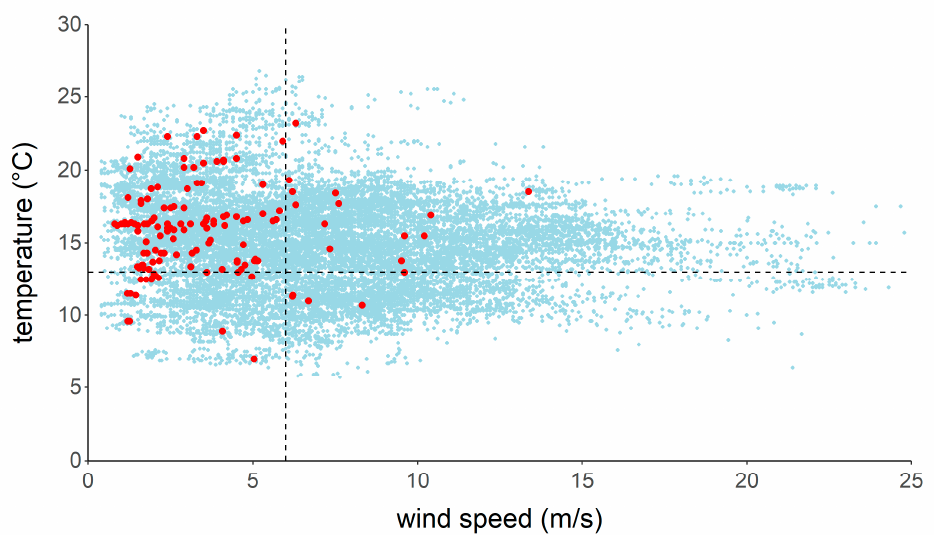
Figure 7. Temperature and wind speed measurements during the survey periods (light blue dots) and temperature and wind speed values when bats were recorded (red dots). Ninety percent of bat recordings were made when the temperature exceeded 13 °C (horizontal dashed line) and wind speed was lower than 6 m/s (vertical dashed line).